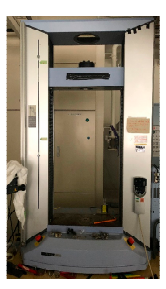
Figure 4. Uniaxial loading testing machine.